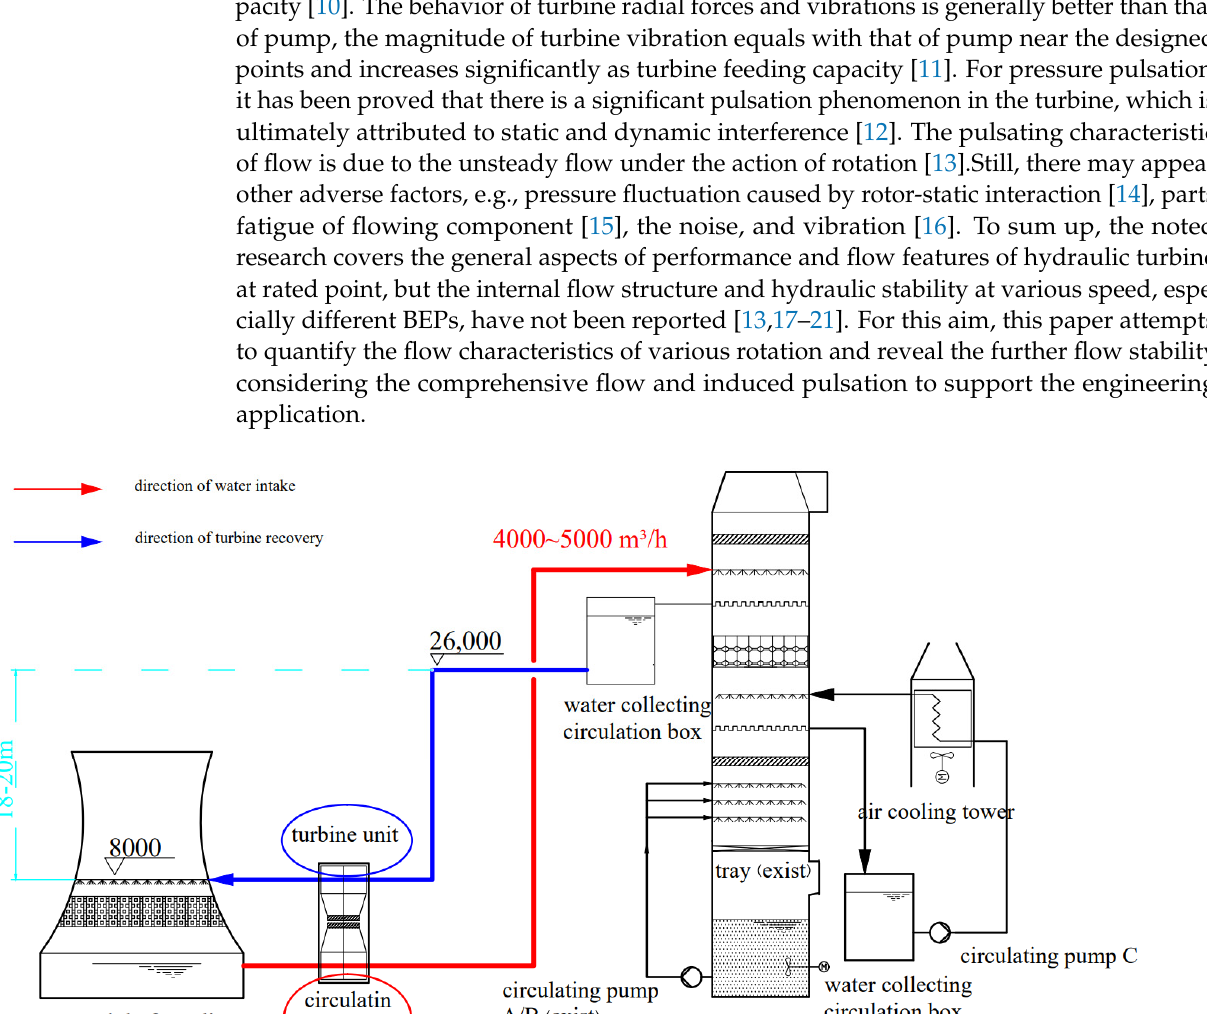
Figure 2. A real application of turbine. 2. Research Object and Theoretical Analysis 2.1. Turbine Main Geometric Parameters A conventional turbine model was chosen to investigate the internal flow stability of various rotating speed. Its rated point was Q = 80 m 3 /h, H = 20.3 m, and N = 1500 rpm. The main graph is shown in Figure 3 and geometric parameters are shown in Table 1.